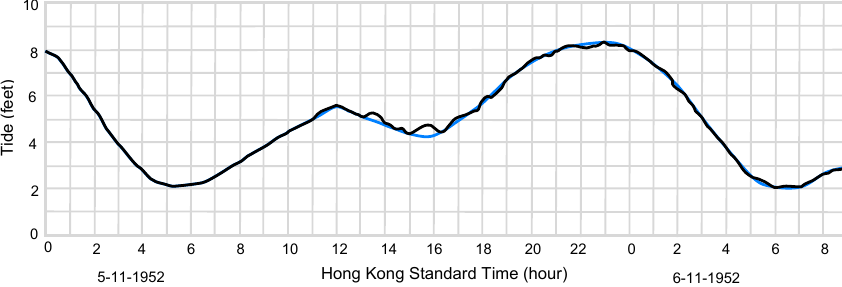
Fig. 3. Tide gauge record of the 1952 Kamchatkan Tsunami at North Point, Hong Kong. Tsunami height of 6inches (15cm), as black line shows, was noted by Royal Observatory, Hong Kong (now Hong Kong Observatory) (adapted from Cheng, 1965, p. 15). The expected normal water level is exhibited by the blue